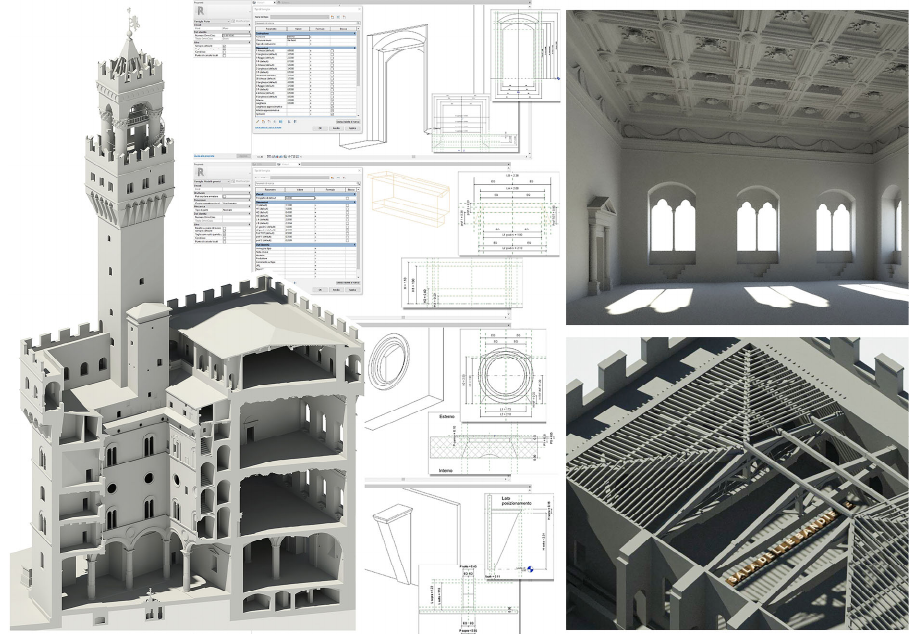
Figure 9. From the building to the BIM model: parametric modeling of the Palace.